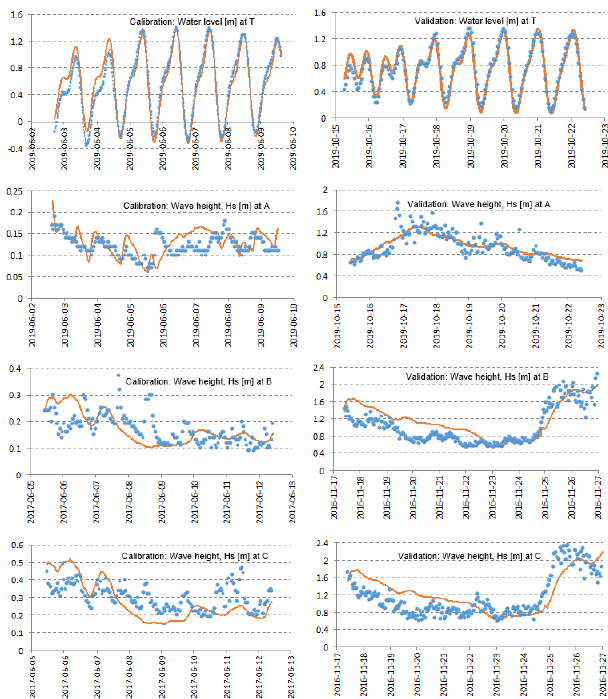
Fig. 4. Calibration and validation results for hydrodynamic (water level at tidal station T) and wave modelling (significant wave height at A, B, and C wave gauges). The solid lines represent computed time series and filled dots denote observed data.